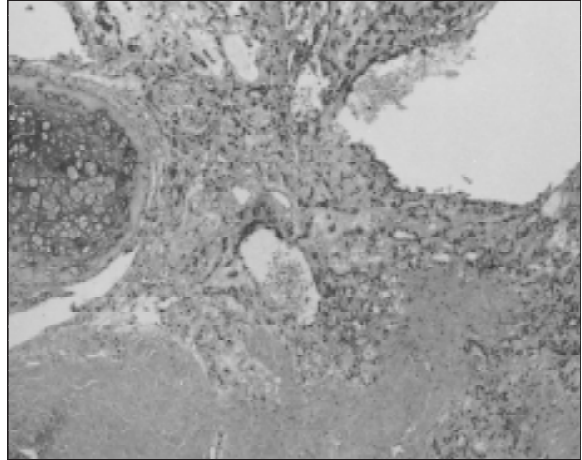
Figura 4 – Ilha de cartilagem hialina (H&E